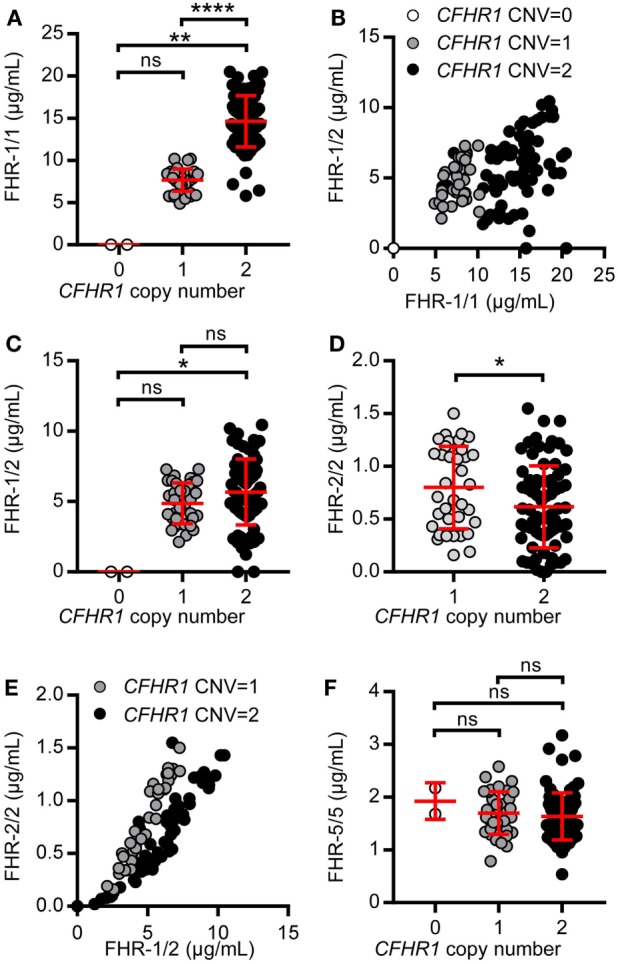
Levels of factor H-related (FHR)-1, FHR-2, and FHR-5 in a healthy donor cohort. A healthy donor cohort (n = 115) was measured for serum levels of FHR-1/1 (A), FHR-1/2 (C), FHR-2/2 (D), and FHR-5/5 (F). Donors are separated based on CFHR1 gene copies, as determined by multiplex ligation-dependent probe amplification (MLPA). (B,E) Depicting the relation between FHR-1/1 and FHR-1/2 levels or FHR-1/2 and FHR-2/2, respectively. (E) Donors who carried no copies of CFHR1 were not included in the graph. Data were analyzed using the Kruskal–Wallis test with Dunn’s test to correct for multiple comparisons (A,C,F), Spearman’s test for correlation (B, E) and a Mann–Whitney test (D).